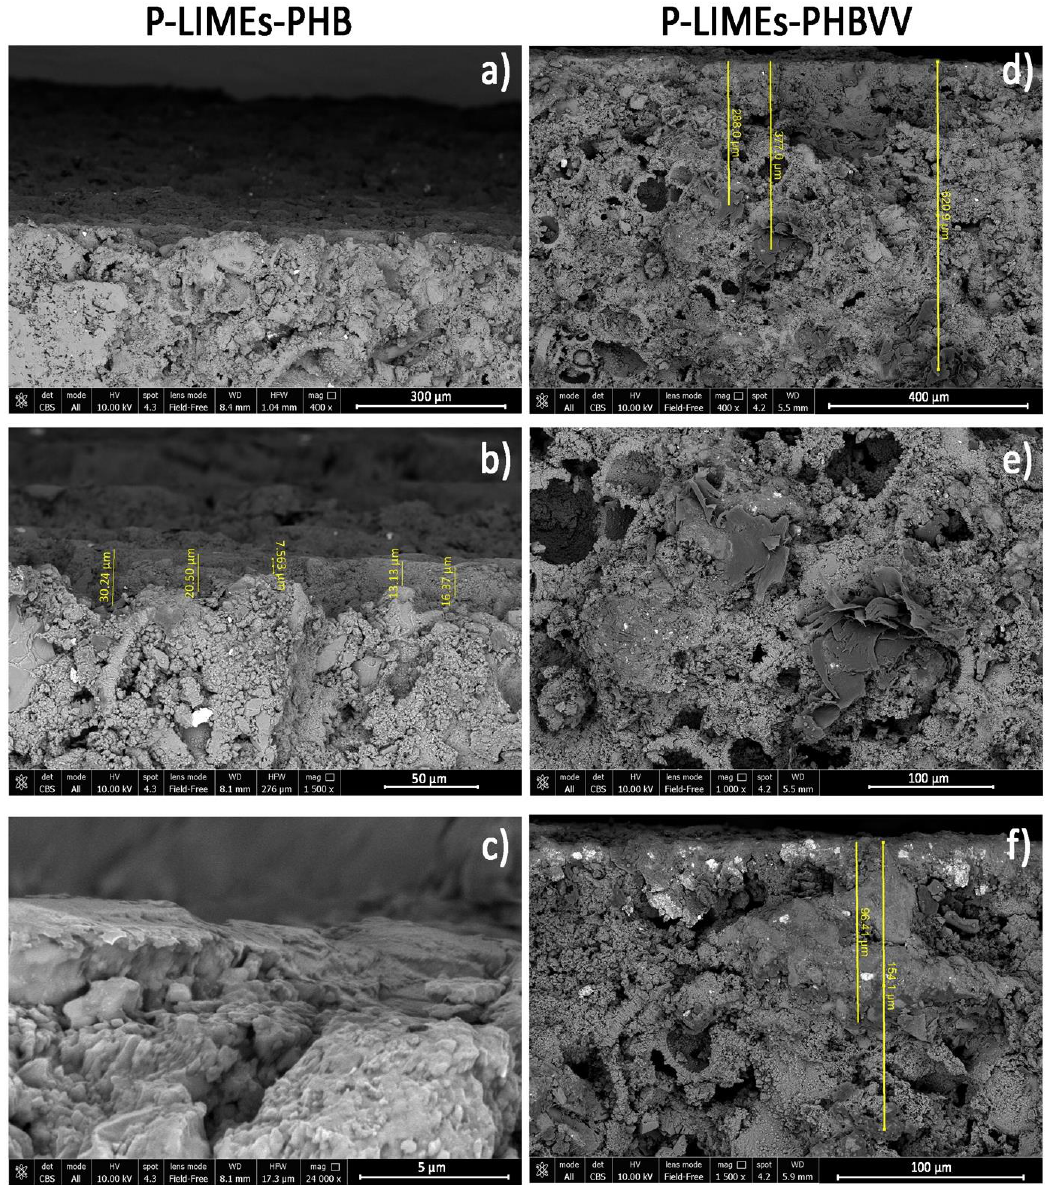
Figure 9. FEG-SEM images of limestone treated: ( a – c ) with PHB-based formulation by poultice; ( d – f ) with PHBVV-based formulation by poultice